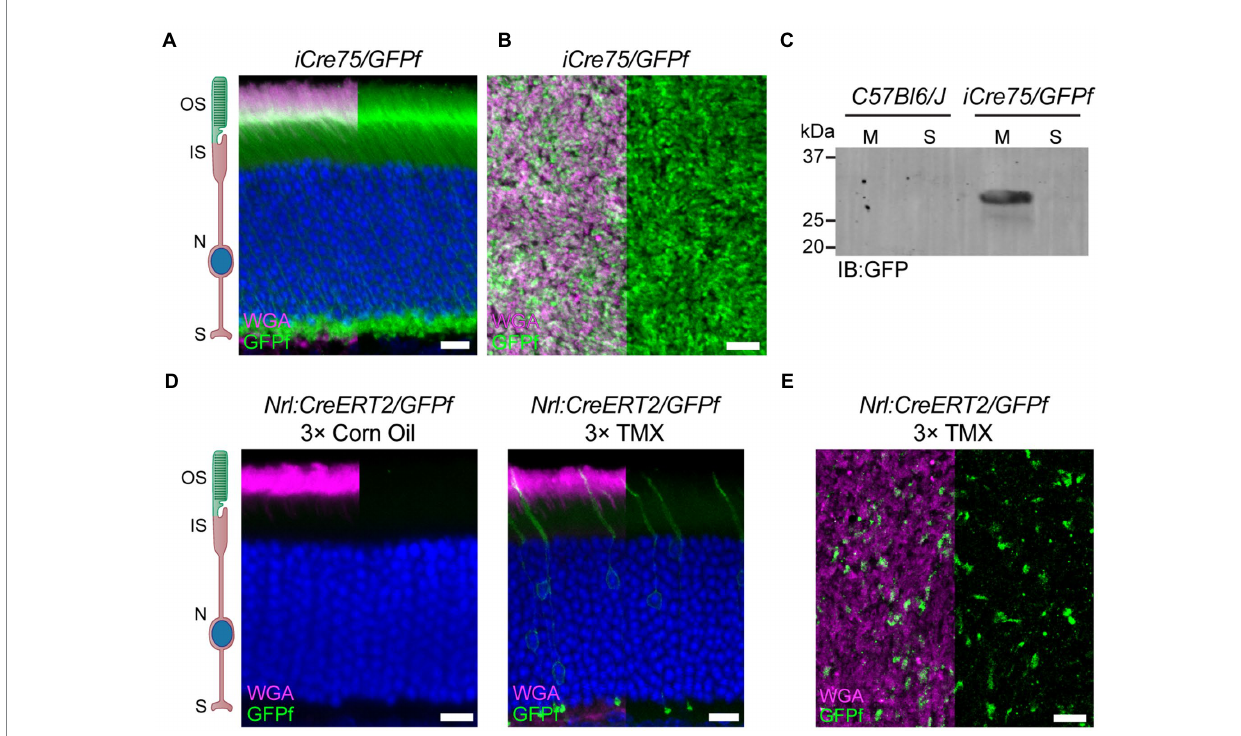
FIGURE 2 Nrl:CreERT2 mouse displays a mosaic pattern of reporter gene expression in rod photoreceptors. (A) Representative retinal cross-section from an iCre75/ GFPf mouse stained with anti-GFP antibody and WGA. Nuclei are counterstained with Hoechst. (B) Representative image of a retinal whole-mount from an iCre75/GFPf mouse stained with anti-GFP antibody and WGA. (C) Membrane and soluble retinal fractions from C57Bl6/J and iCre75/GFPf mice immunoblotted (IB) for GFP. (D,E) Nrl:CreERT2/GFPf mice were injected 3 consecutive days with either tamoxifen or corn oil. Eyes were collected 2 weeks post-injection. (D) Retinal cross-sections stained with anti-GFP antibody and WGA. Nuclei are counterstained with Hoechst. (E) Retinal whole-mount stained with anti-GFP antibody and WGA. Scale Bars, 10 μ m. Here and in all figures: outer segment (OS), inner segment (IS), nuclei (N), and synapse (S).